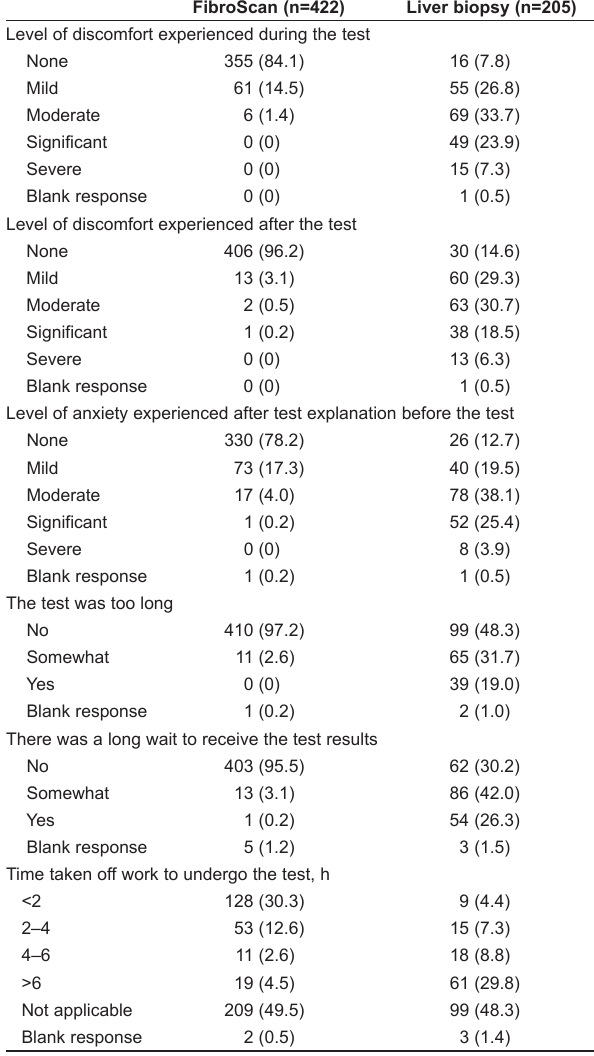
TABLE 3 Survey responses regarding transient